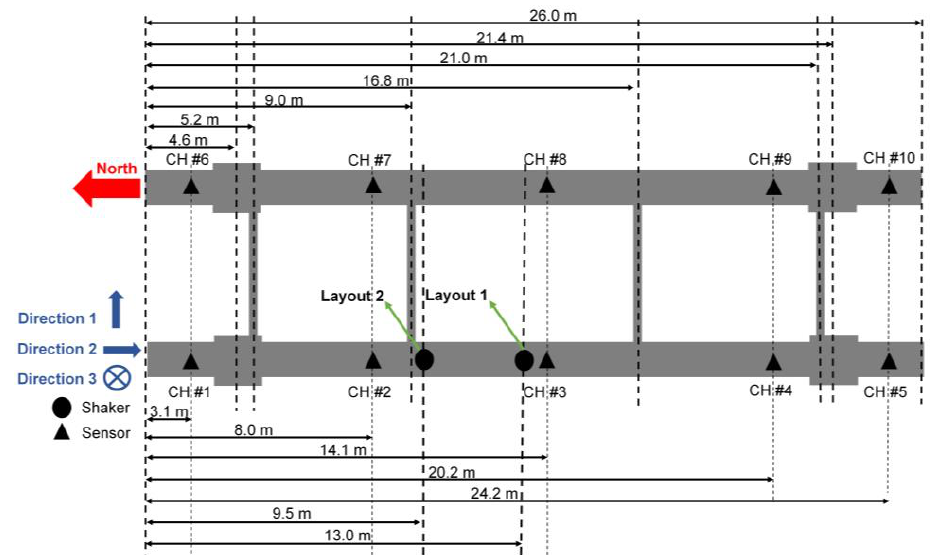
Figure 4. Test layout including the sensor and shaker locations.